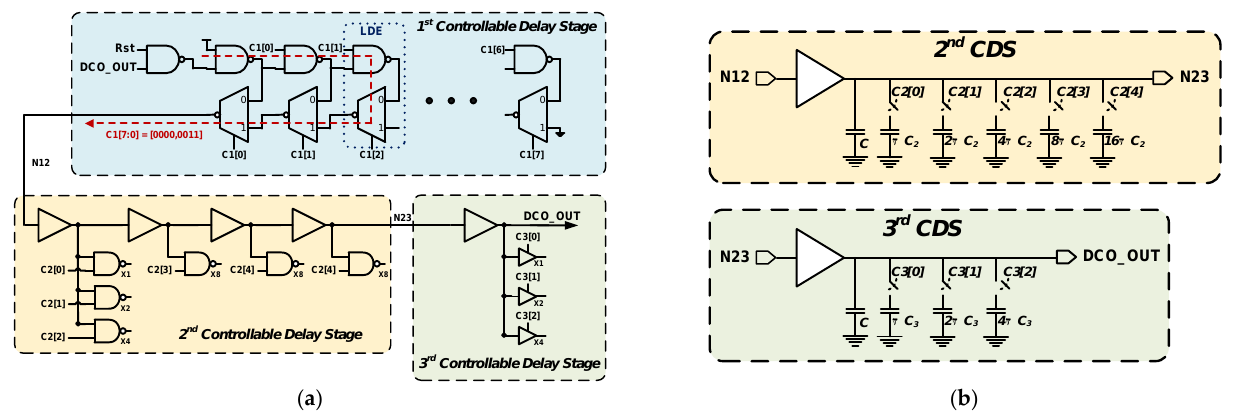
Figure 5. ( a ) The detailed circuit of the proposed multistage digitally controlled oscillator (DCO); ( b ) The equivalent circuits of the second and third CDSs.